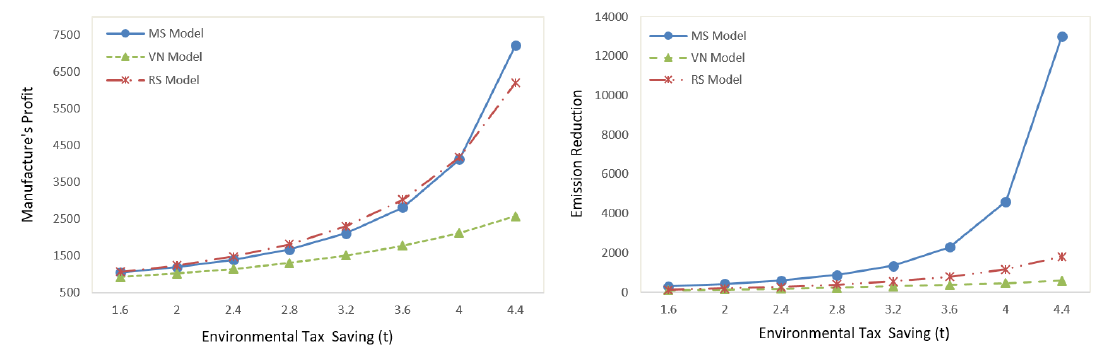
Figure 5. Impact of the environmental tax savings on the ( left ) manufacturer’s profits and ( right ) emission reduction in different power